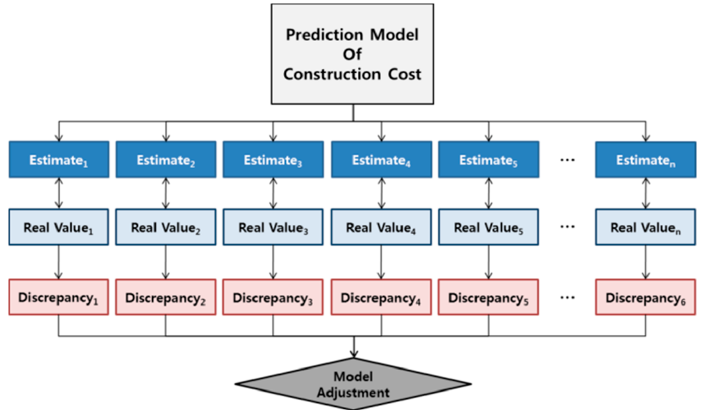
Figure 5. Final correction of the model based on estimation results.